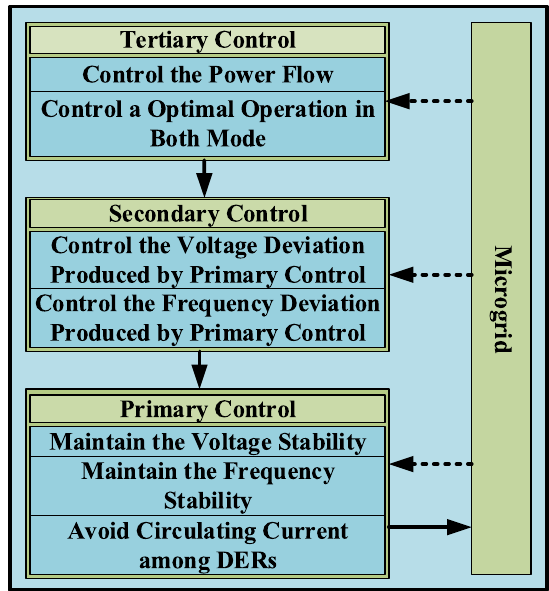
Fig. 14 Block Diagram of Hierarchical Control System